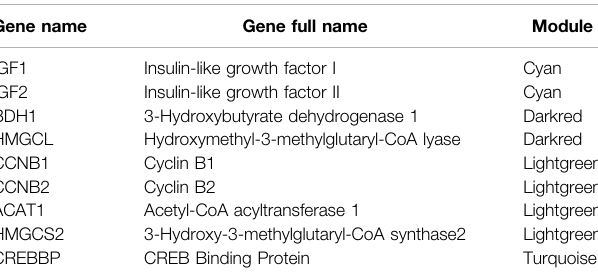
TABLE2| DescriptionofpotentialDEGsthatassociatedwithrumendevelopment from different